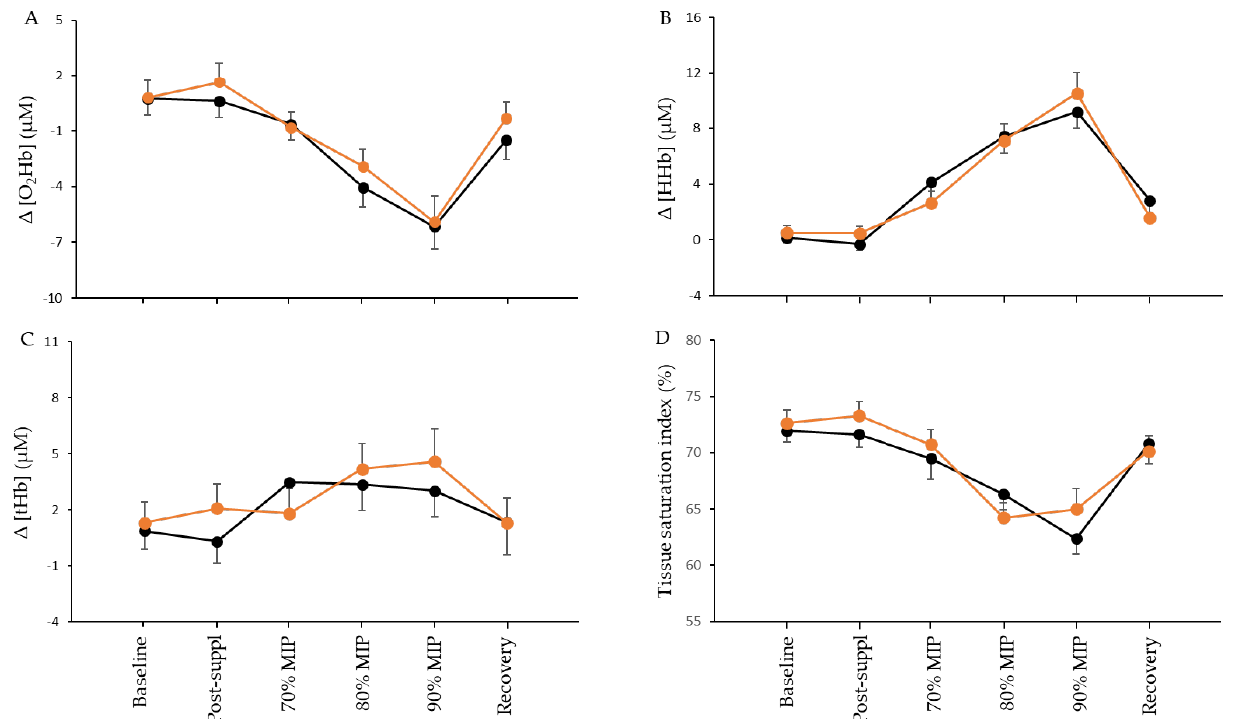
Figure 5. Sternocleidomastoid muscle oxyhemoglobin (O 2 Hb) ( A ), deoxyhemoglobin (HHb) ( B ), total hemoglobin (tHb) ( C ), and tissue saturation index ( D ) at baseline, after seven days of L-citrulline (or- ange circles) and placebo (black circles) supplementation and post resistive breathing to task failure.